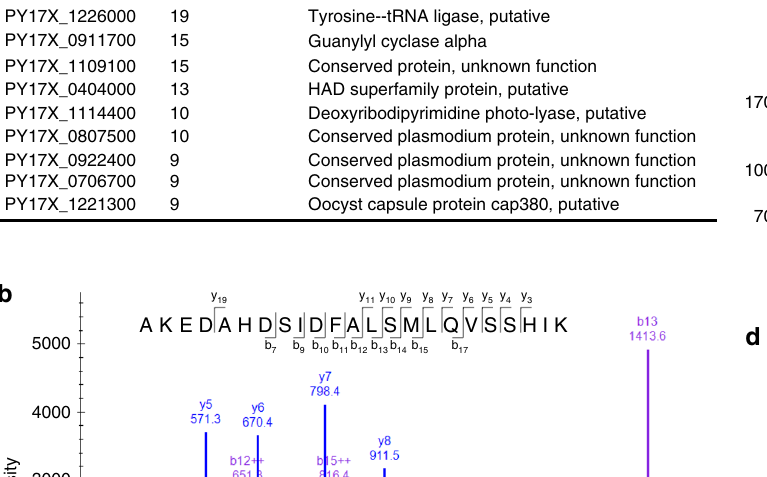
The promoter replacement allowed expression of the GC α protein in asexual blood stages at a level comparable with that of another parallelly modi fi ed parasite 6HA::gc α (Supplementary Fig. 1j), but signi fi cantly reduced GC α protein expression in gametocytes (Fig. 6b, c). Notably, the gc α kd parasite completely lost the ability to synthesize cGMP and form ECs after XA stimulation in vitro (Fig. 6d, e). In mosquitos fed with gc α kd parasite-infected mouse